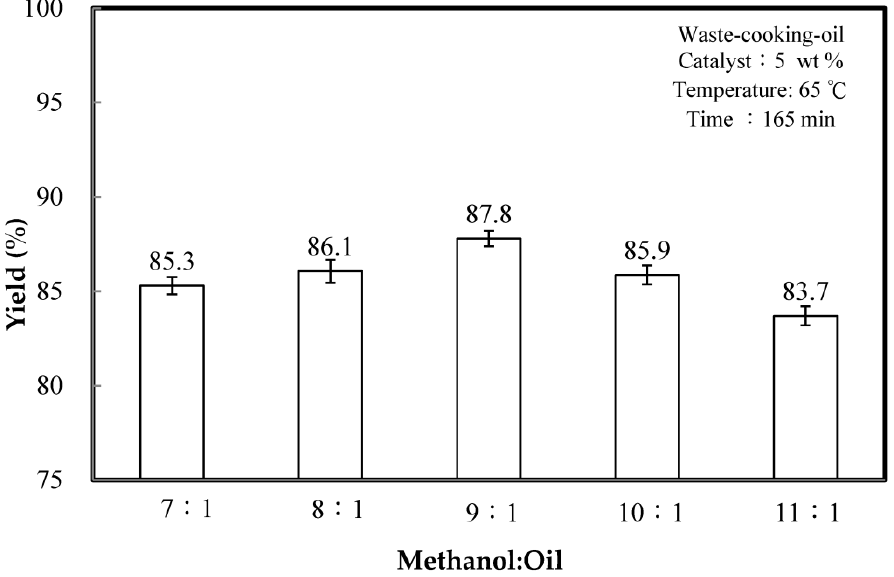
Figure 7. Effects of methanol-to-oil molar fraction.